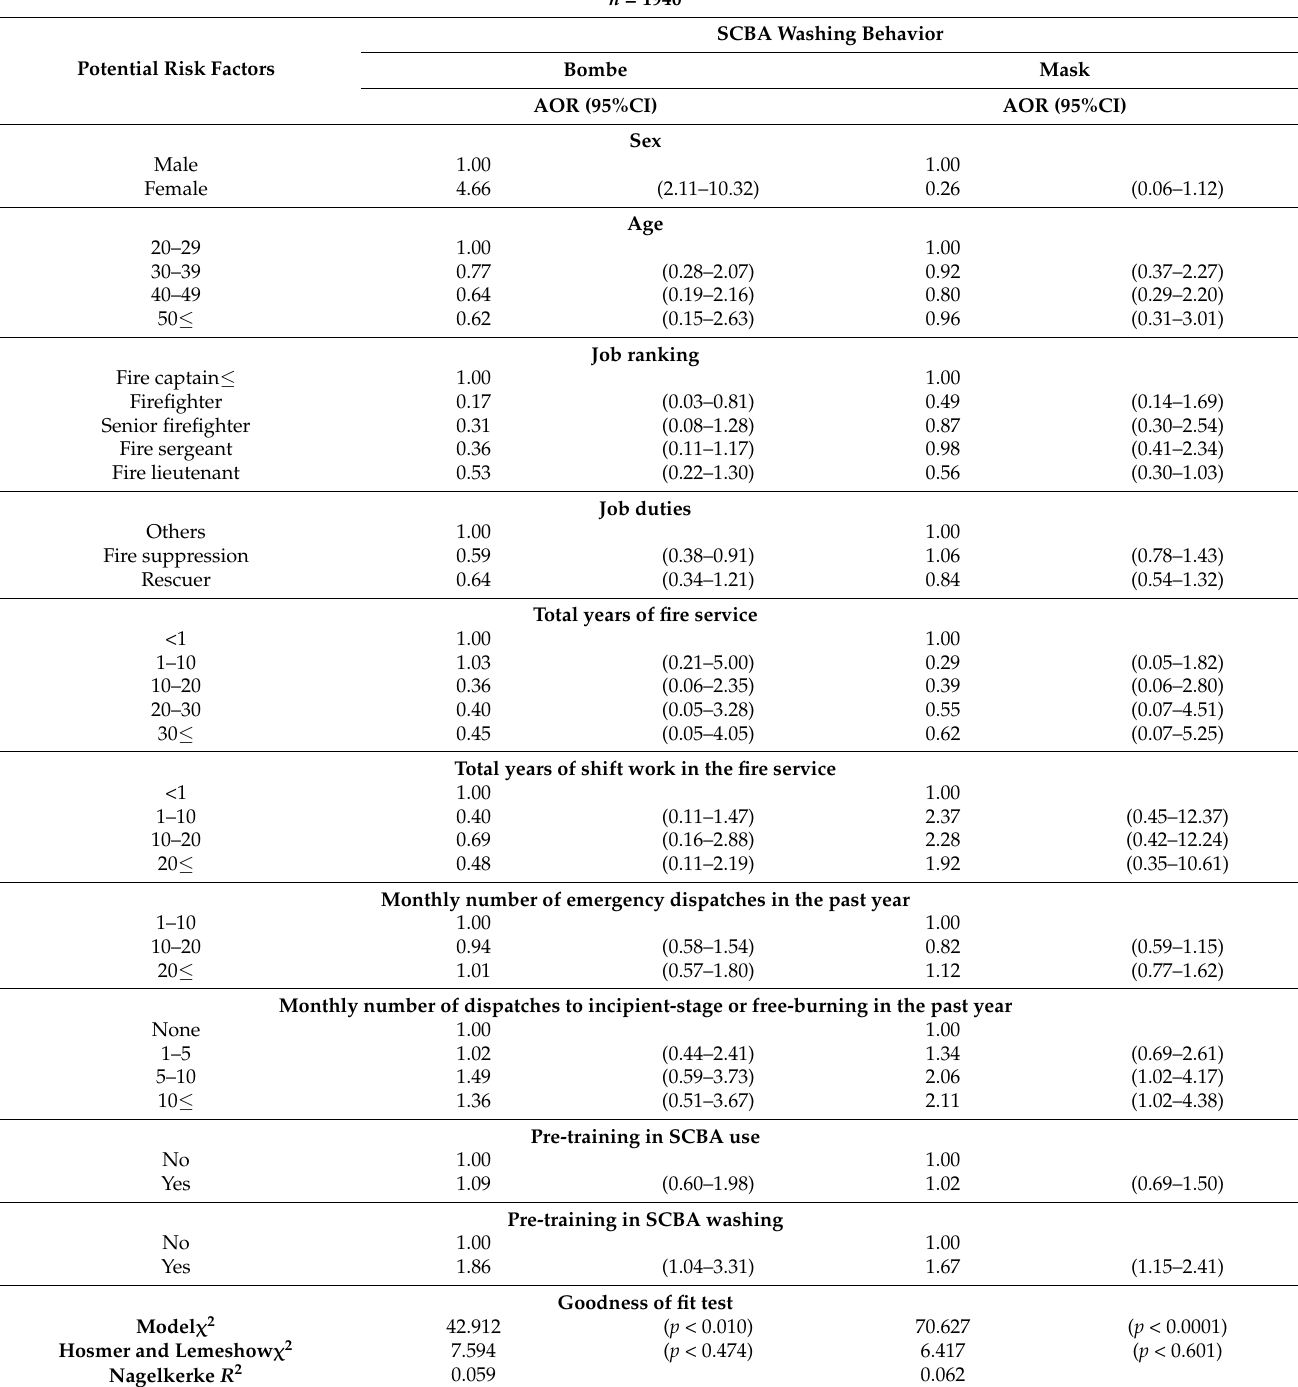
Table 3. Factors influencing SCBA